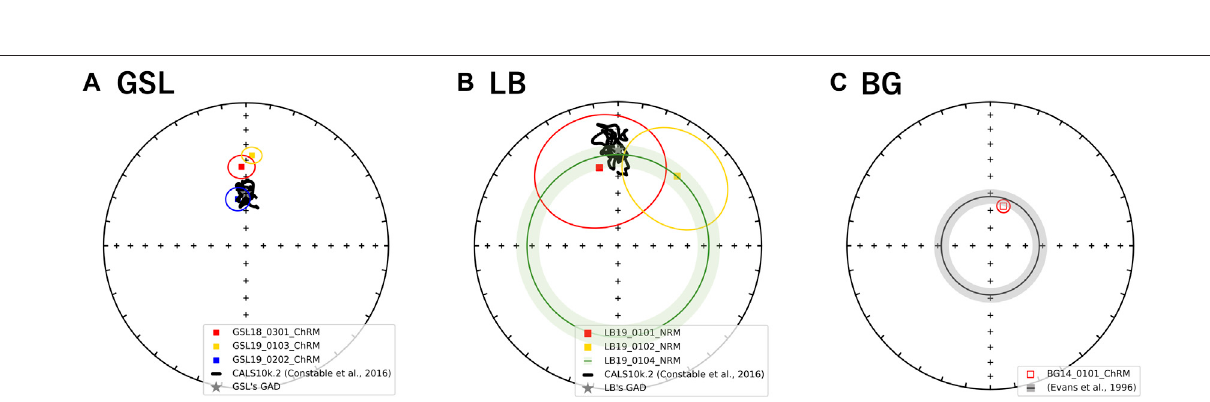
Frontiers in Earth Science |